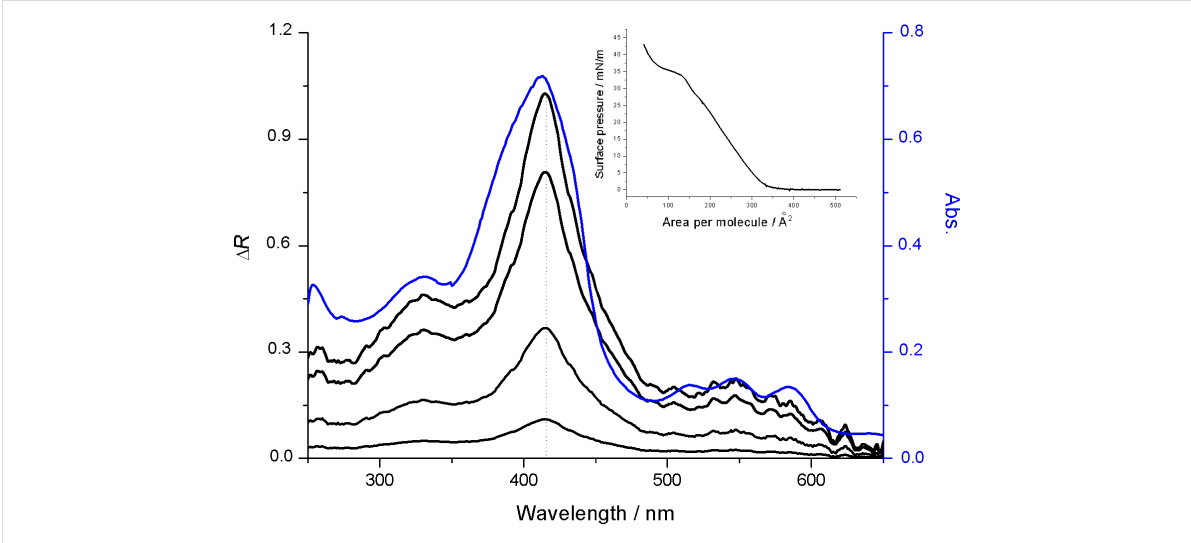
Figure 3: UV–vis solution spectrum (blue line) and reflection spectra of the Cu,H 2 -Por 2 Langmuir film (black lines). The maximum reflection peak is centered at 414 nm for all the investigated surface pressures (2, 16, 35 and 40 mN/m), suggesting a closed form of the bis-porphyrin derivative as the major conformer. In the inset, the surface pressure vs area per molecule curve is reported.